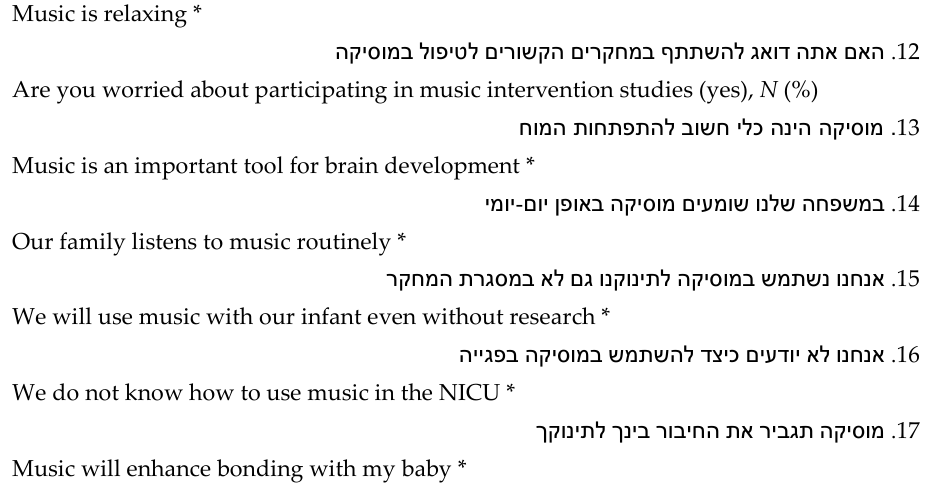
Figure 1. Questionnaire in the original Hebrew followed by the English translation. Responses were based on a five-point Likert scale of: (1) Strongly disagree, (2) Disagree, (3) Neither agree nor disagree, (4) Agree, or (5) Strongly agree. Not applicable (N/A) was an optional answer. Questions assessed factors that have been suggested to affect consent. These included altruism, attitudes toward research for preterm infants in